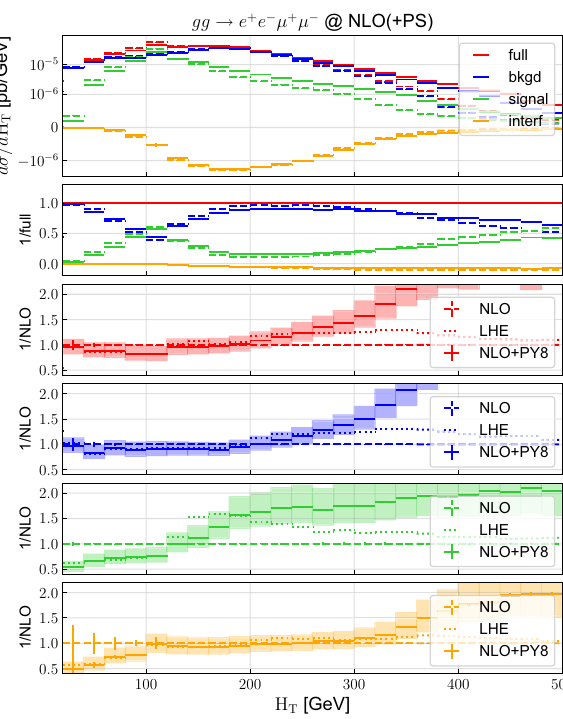
Fig. 4 Differential distribution in H T in gg → e + e − μ + μ − at NLO matchedto PYTHIA 8 .Predictions,colourcodingandbandsasinFig.3